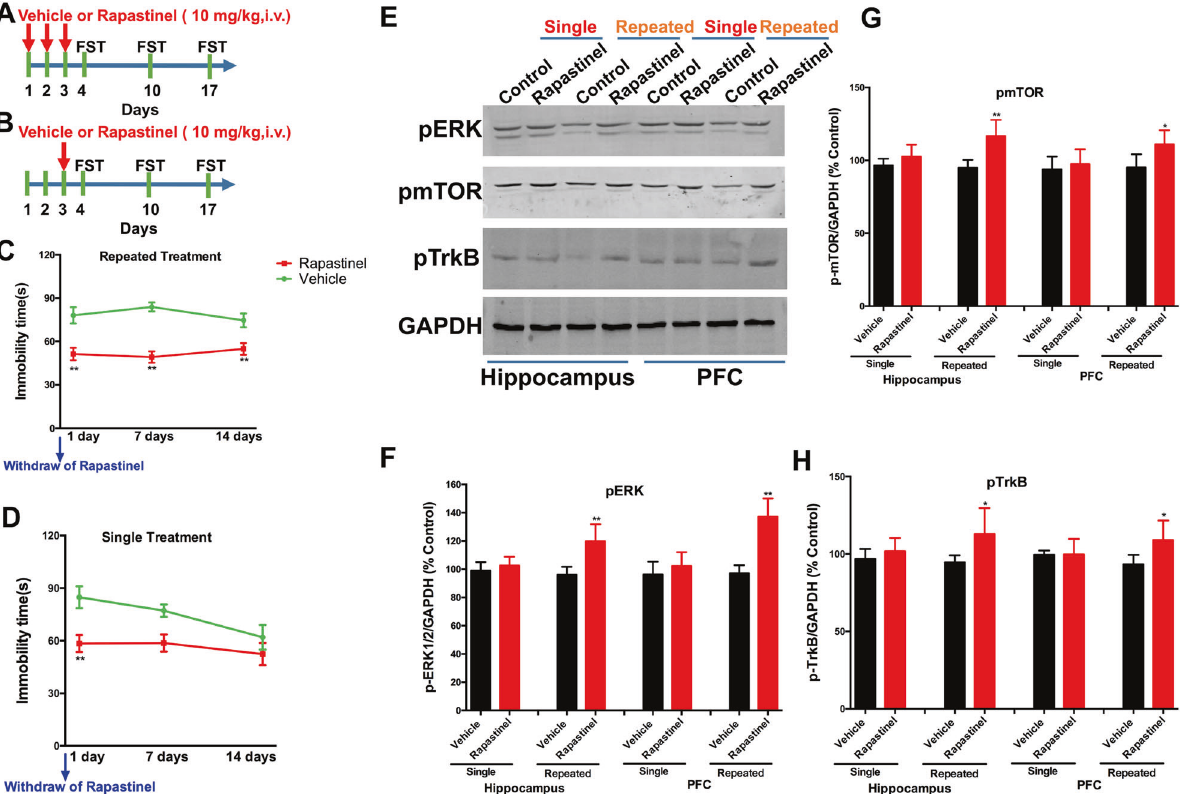
Fig. 1 The antidepressant-like effects of repeated or single treatment with rapastinel and changes in the expression of p-ERK, p-mTOR, and p-TrkB in mice. A and B Experimental timeline schematic. C Repeated treatment with rapastinel signi fi cantly decreased the immobility time at 1, 7, and 14 days after withdraw of rapastinel. D However, single treatment with rapastinel signi fi cantly produced signi fi cant inhibition in immobility time only at 1 day after withdrawal of rapastinel. Our data indicated that repeated treatment with rapastinel induced the signi fi cant antidepressant-like effects in the FST of mice. However, single treatment with rapastinel induced antidepressant-like effects that only lasted a week. Based on our hypothesis about the VGF/BDNF/TrkB autoregulatory feedback loop and increase of ERK/mTOR signaling that may induce the signi fi cantly antidepressant-like actions, we performed western blotting to detect the levels of p-ERK, p-mTOR, and p-TrkB in the hippocampus and PFC of mice ( E ). Repeated treatment with rapastinel showed a signi fi cant increase in p-ERK ( F ), p-mTOR ( G ), and